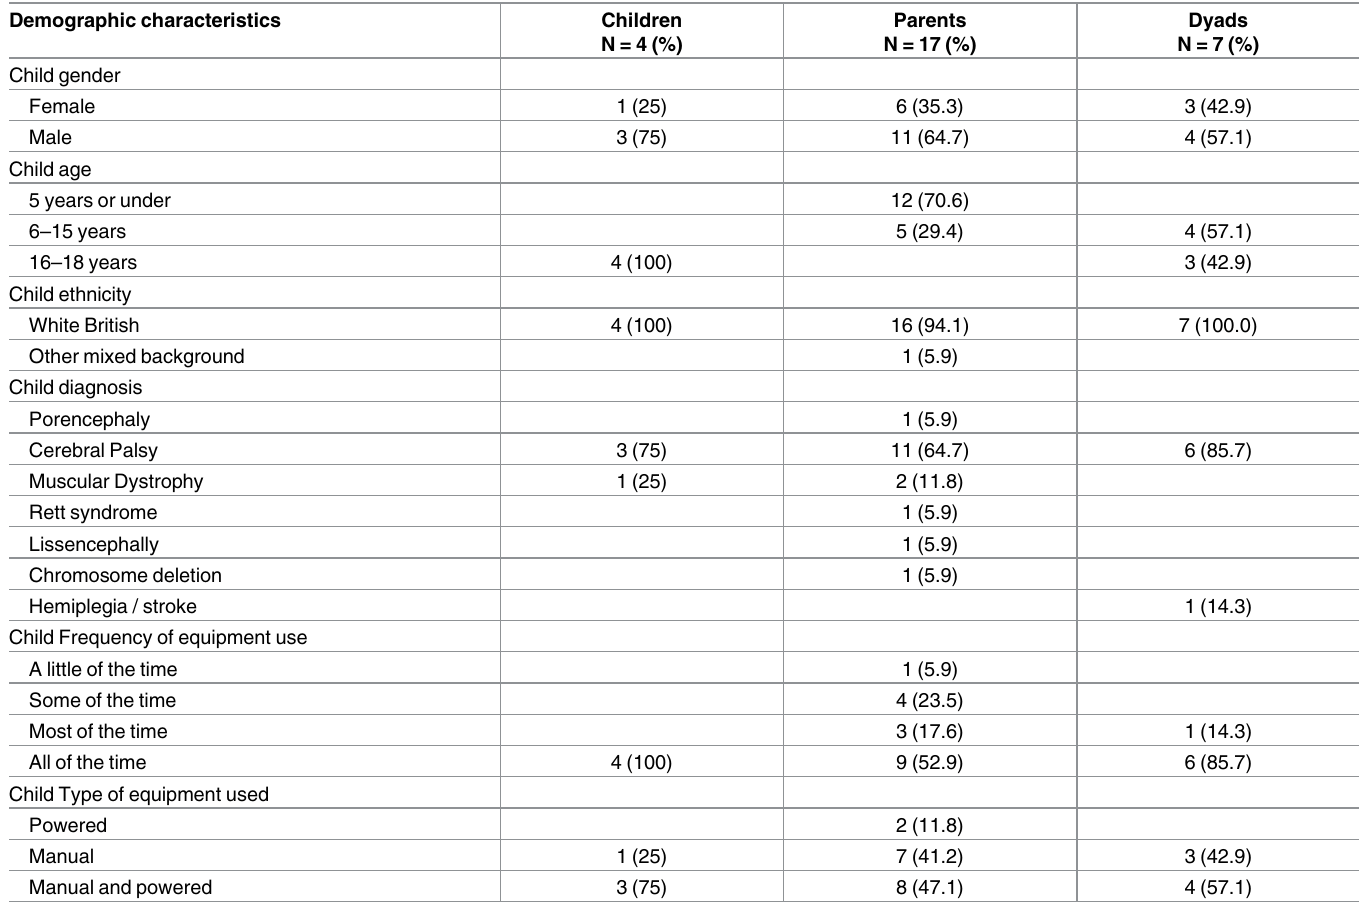
Table 1. Child demographic characteristics (child, parent and dyad